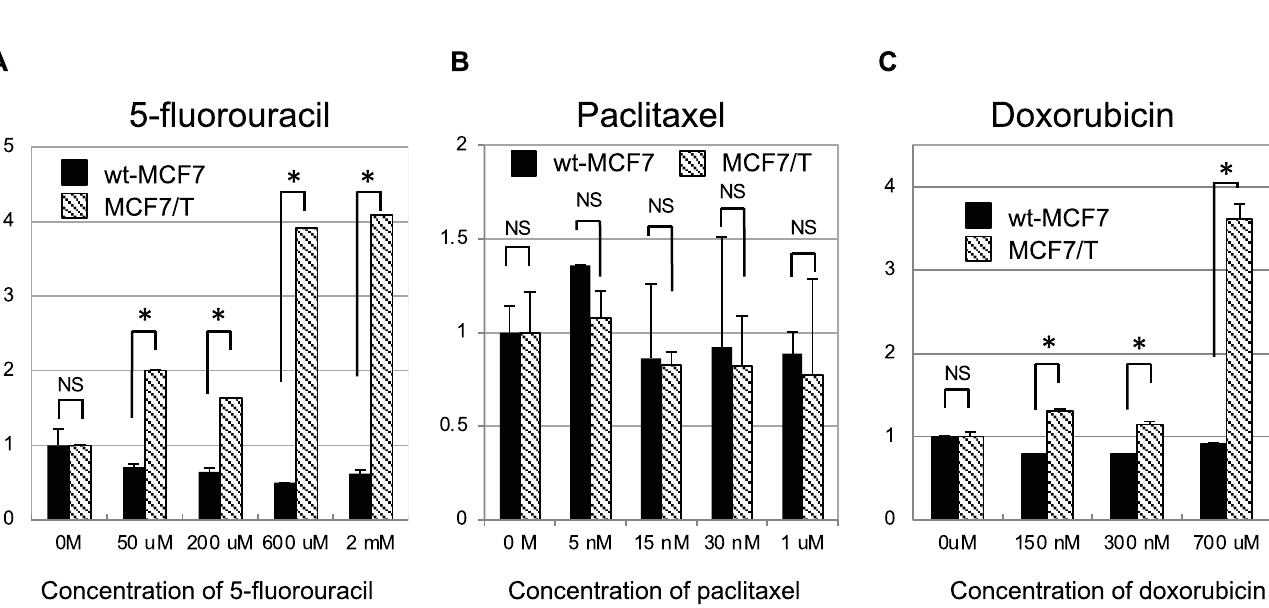
Fig 3. Apoptosis induced by chemotherapeutic agents in ER-positive breast cancer cell lines and their tamoxifen-resistant sublines. The effect of 5-fluorouracil (A), paclitaxel (B), and doxorubicin (C) on apoptosis in wild-type and TAM-resistant MCF7, T47D, and BT474 cells was examined. The Cell Death Detection ELISA plus kit was used to quantify apoptosis in the presence of 5-fluorouracil (50 μ M–2 mM), paclitaxel (5 nM–1 μ M), or doxorubicin (150 nM–700 μ M) for 48 h. The error bars represent the standard deviations of the values obtained; each experiment was performed in duplicate. The experiments were repeated independently at least three times, and one representative result is provided in the figures. NS, not significant; � p < 0.05, unpaired Student’s t -tests.